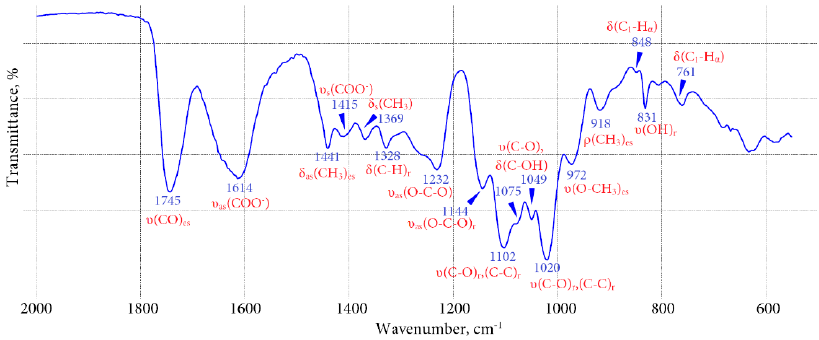
Figure 1. FT-IR spectra of water-soluble polysaccharide fraction of G. algida bitter tea.